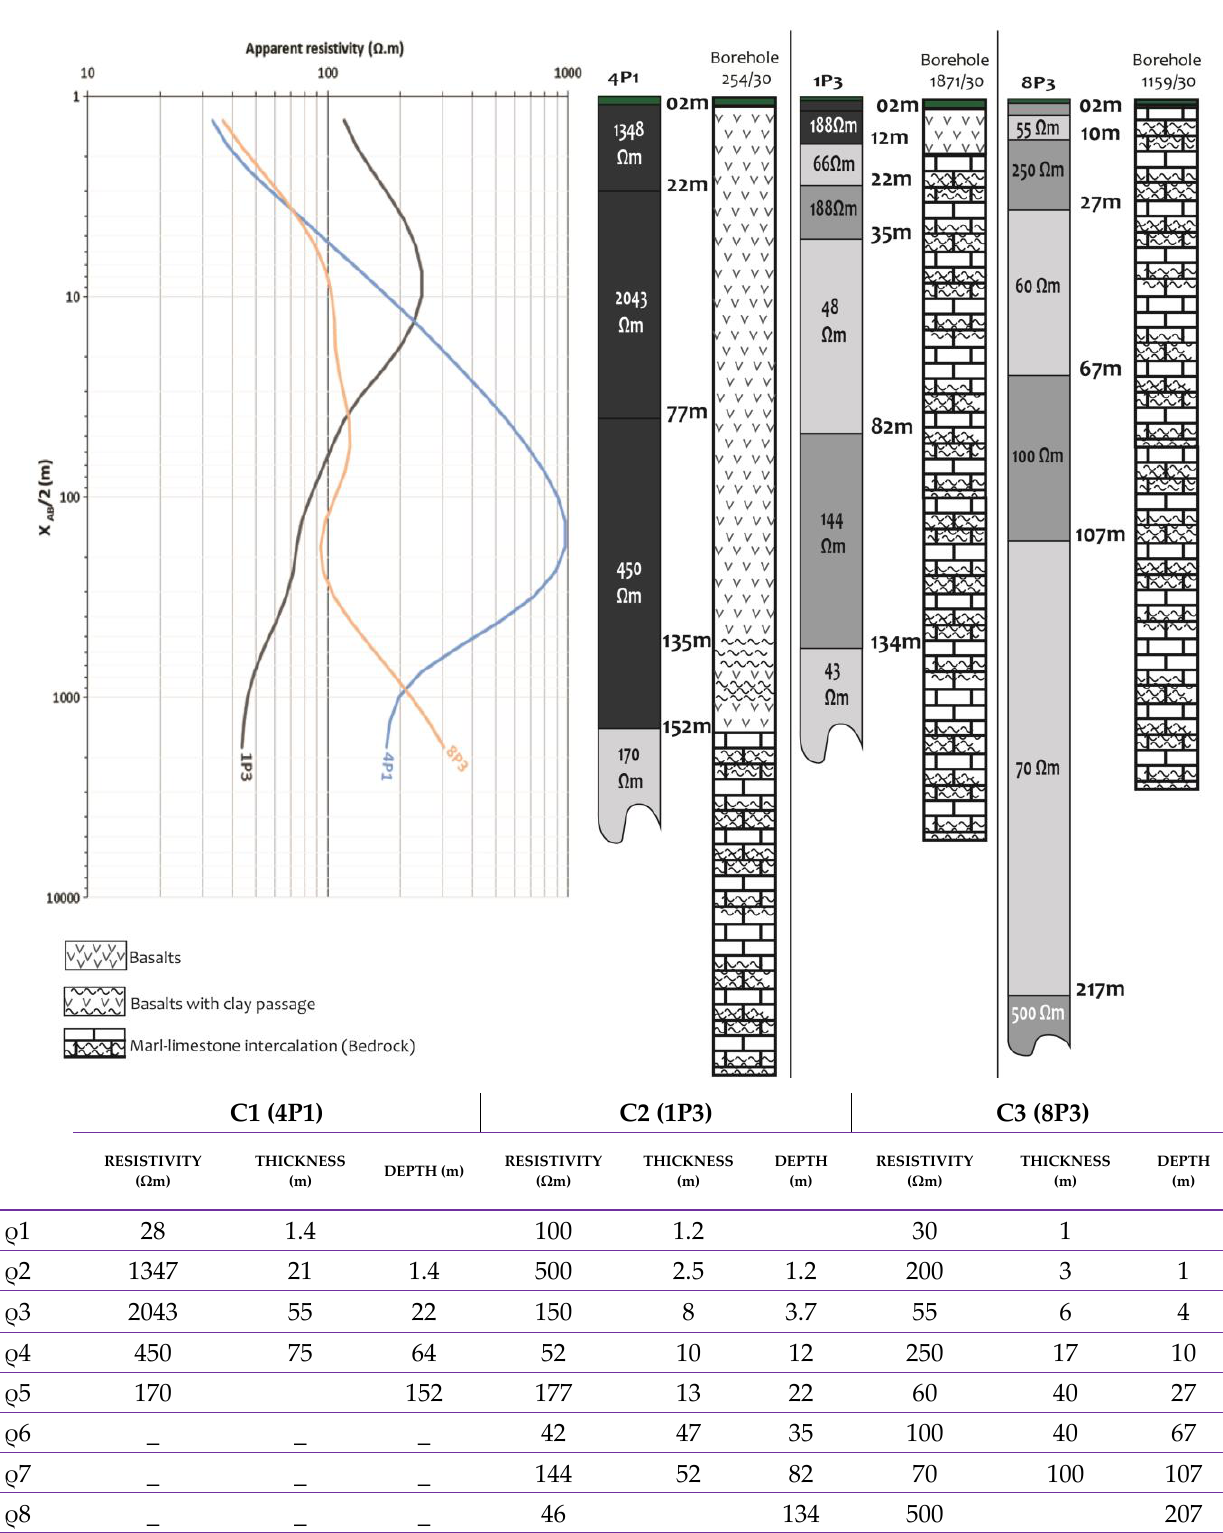
Figure 5 . Diagrams and interpretation models of typical SEV of each category and the borehole data with its corresponding lithological logs.